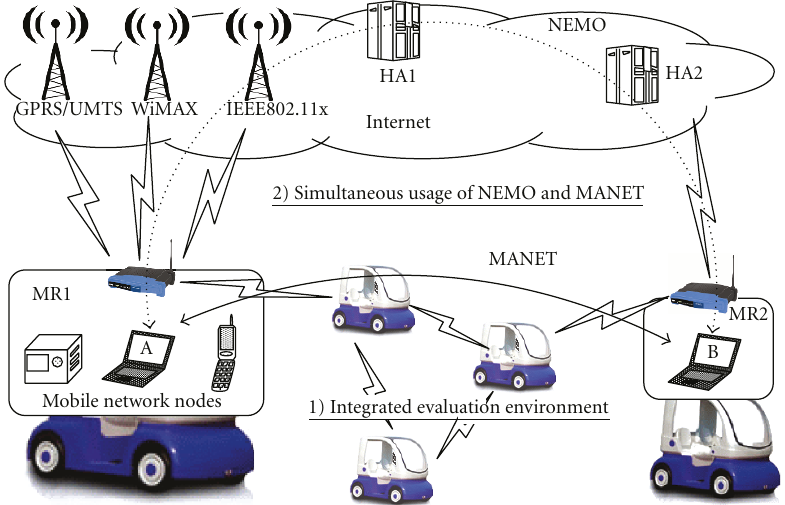
Figure 1: Generic intervehicle communication scenario. Network nodes inside vehicles communicate with their peers via the VANET or through the Internet using NEMO.